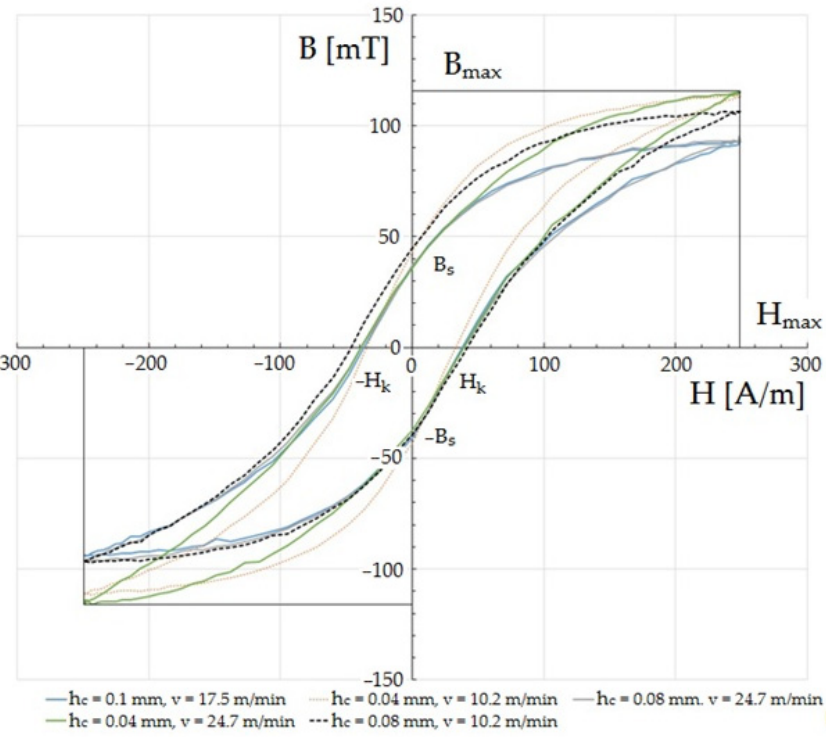
Figure 15. Influence of selected values of input factors of the cutting process on the magnetic characteristics B (H) of the ET 110-30LS sheet.